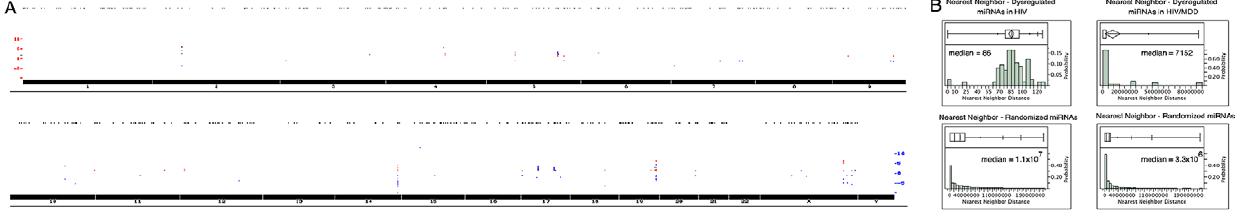
Figure 2. Chromosomal locations of dysregulated miRNAs. (A) Map of genomic locations of miRNAs dysregulated in HIV (red) and HIV/MDD (blue). (B) Distribution of nearest neighbor distances of dysregulated miRNAs in HIV (left) and HIV/MDD (right) and the distribution of nearest neighbor distances if randomly chosen miRNAs were calculated. The chromosomal locations were mapped in (A) using Supplementary Files S3, S4, S5 in the UCSC Genome Browser, for comparison, locations of all human miRNAs are shown in black. For each miRNA dysregulated, the distance to the nearest dysregulated neighbor was calculated in basepairs; and the distribution of distances was plotted in (B) along with the distribution calculated if miRNAs were randomly chosen from all known human miRNAs and nearest miRNA were calculated.